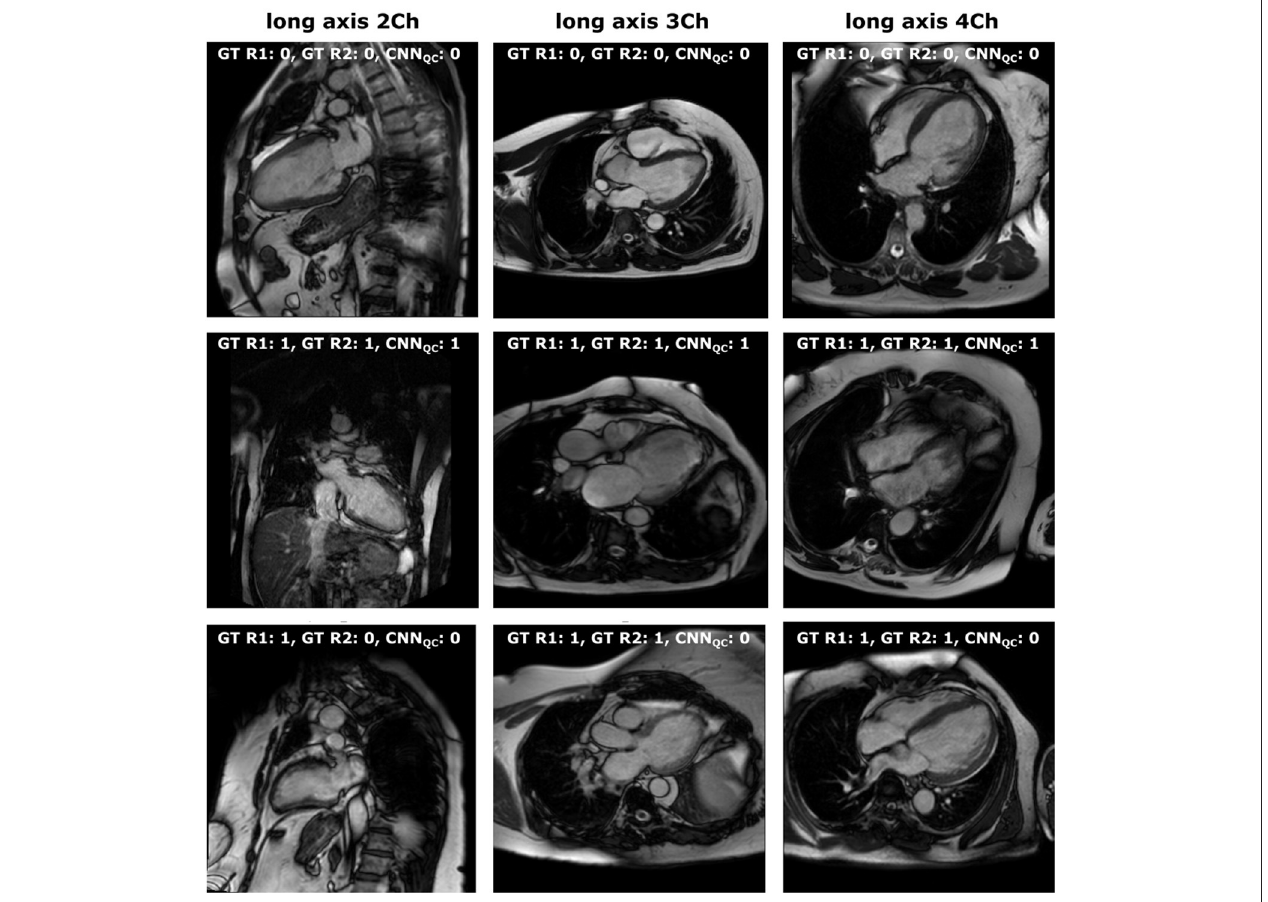
FIGURE 2 | Manual vs. automated classification. Visual representation of: (first line) cases classified as “correct” both by manual assessment (both operators) and CCN QC ; (second line) cases classified as “wrong” both by manual assessment (both operators) and CCN QC ; (third line) cases classified as “wrong” by manual assessment (with disagreement between operators for 2-chamber) and as “correct” by CCN QC . 0, correct; 1, wrong; Ch, chamber; GT, ground truth; R1, first operator; R2, second